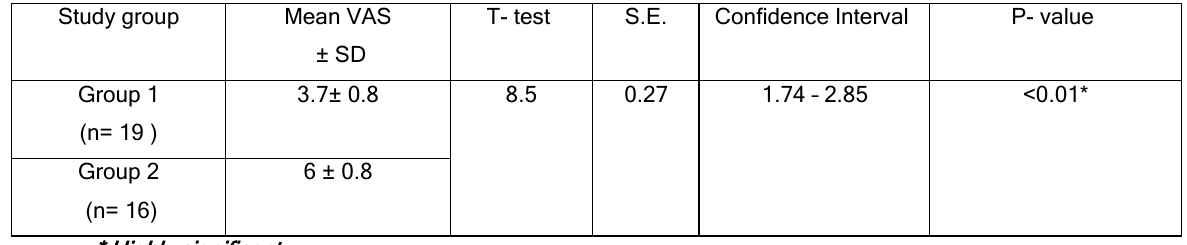
Table (5): A comparison between study groups in current study regarding VAS after 1 year of operation. Study group